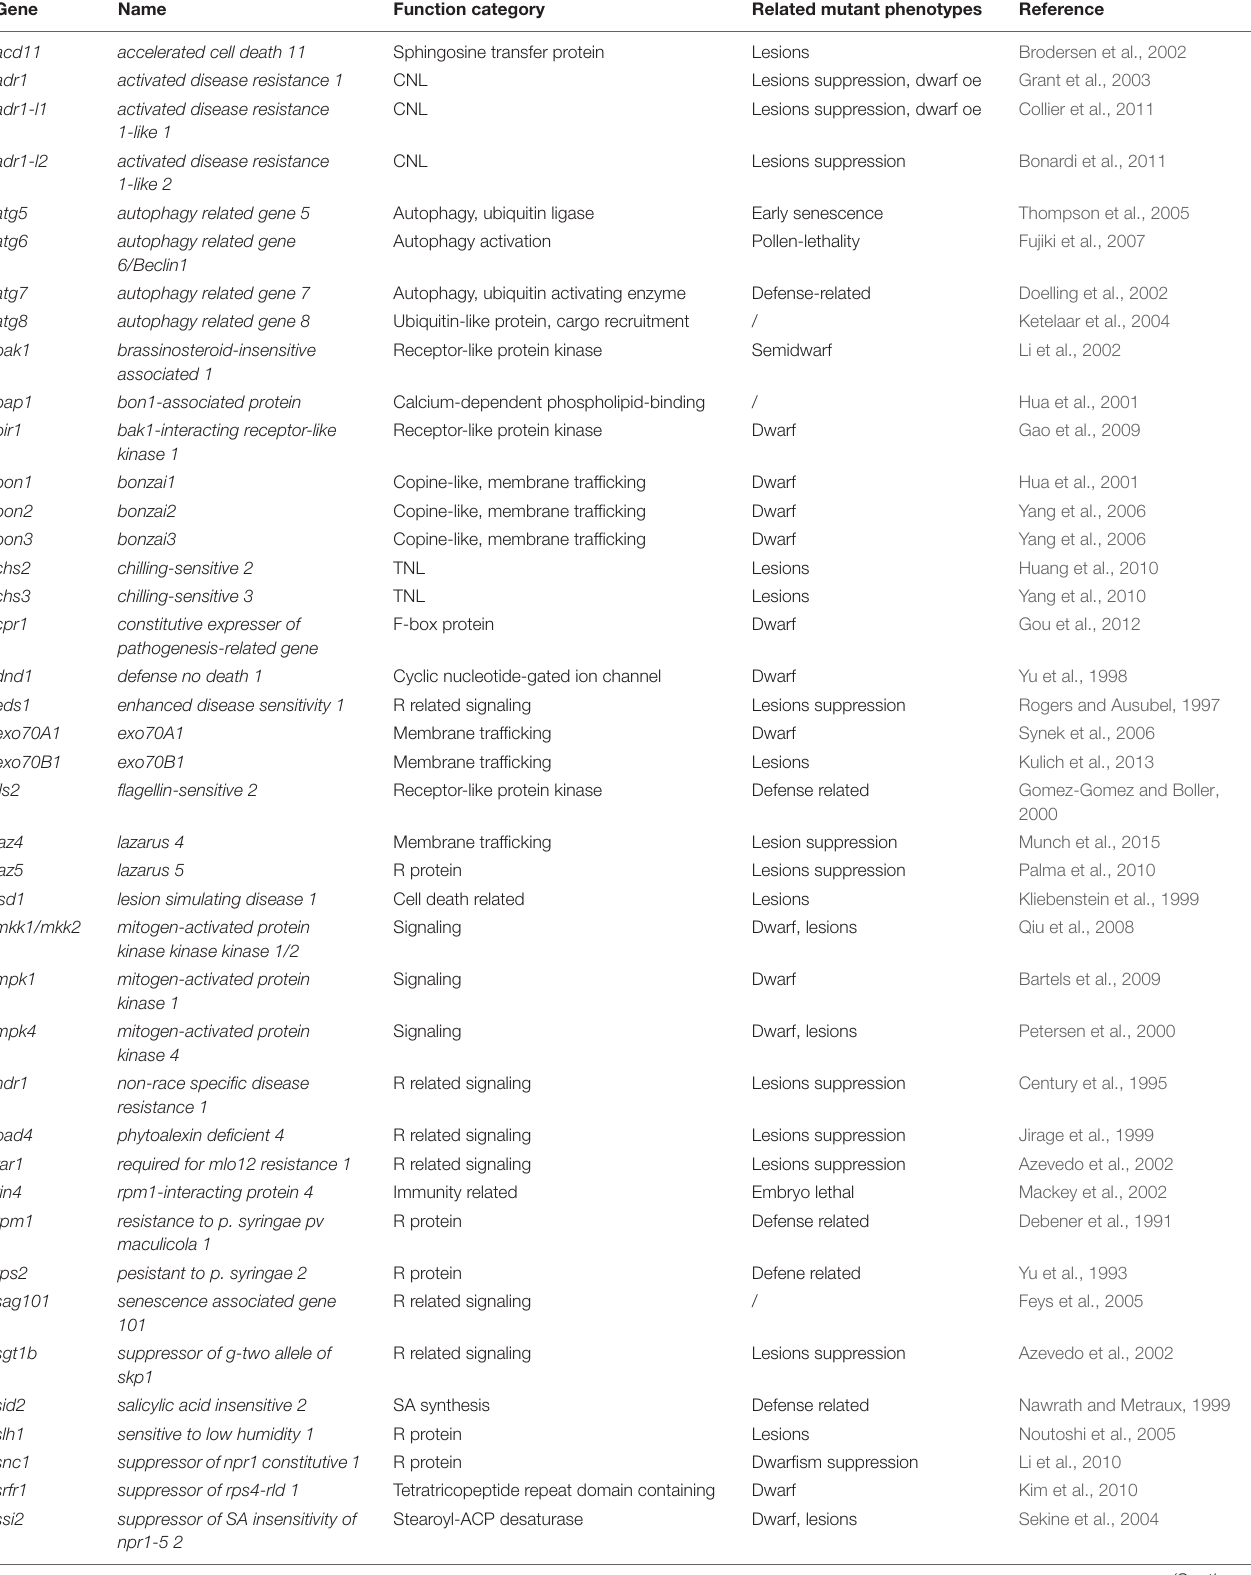
TABLE 1 | List of Arabidopsis mutants related to R proteins hyper activity causing dwarf and lesion mimic